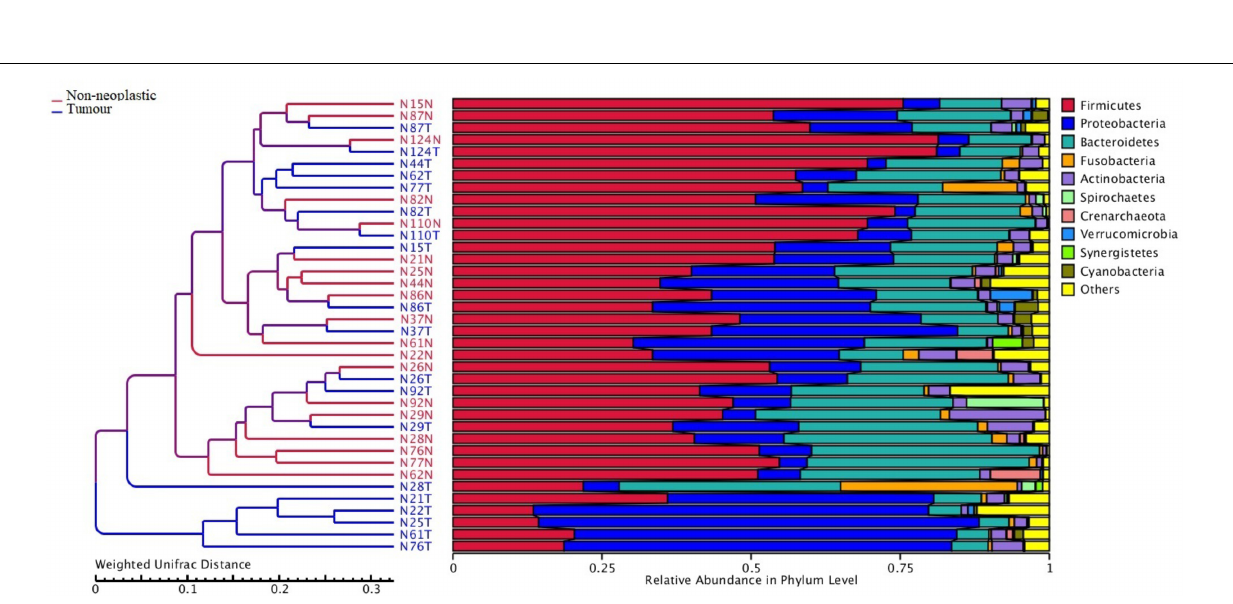
Frontiers in Microbiology |